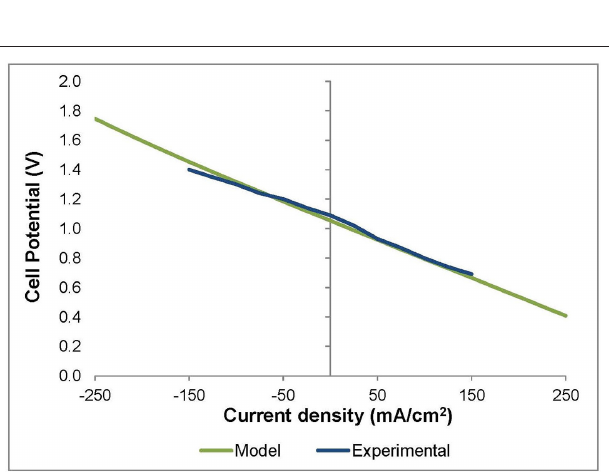
FIGURE 2 | Model and experimental curves representing the cell potential (V) as a function of the current density (mA/cm 2 ) in both electrolysis cell (left) and fuel cell (right)